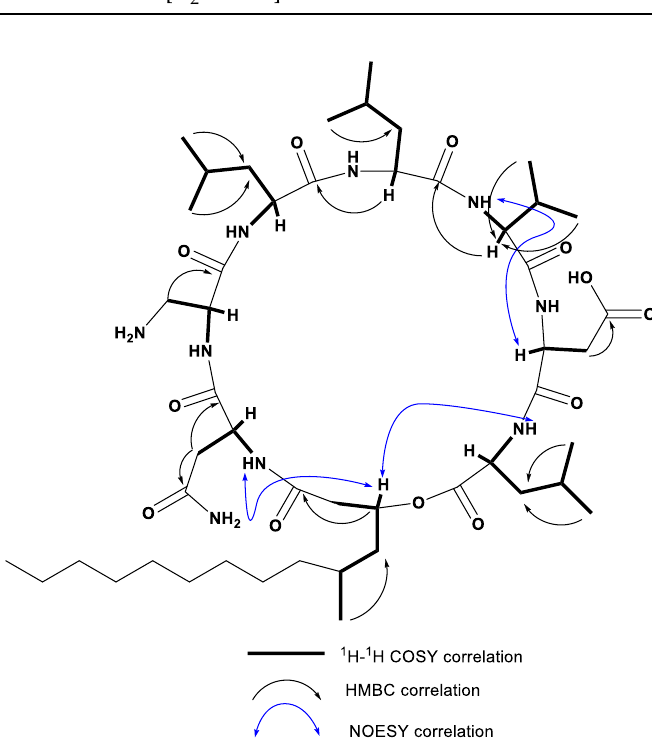
Figure 2. Selected correlations of COSY, HMBC, and NOESY observed for compound 1 .